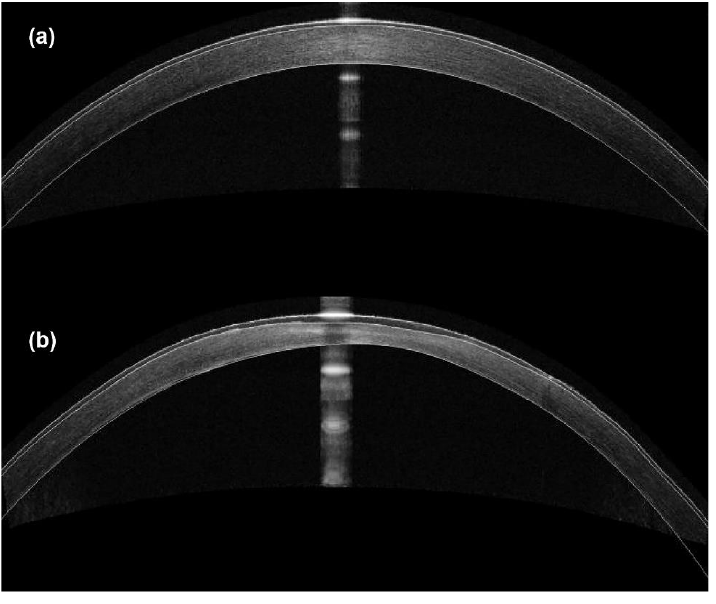
Figure 5. The representative SD-OCT images of the cornea ( a ) preoperatively and ( b ) at 4 weeks postoperatively.